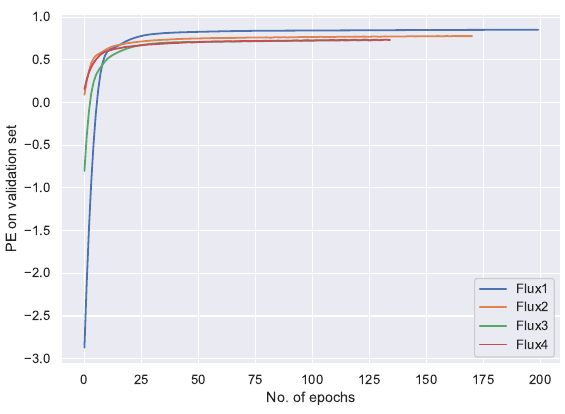
Figure 6. Predictive efficiency (PE) on validation set as a function of the number of epochs for Multi-Layer Perceptron (MLP) with input feature RL12A12 for the four targets (Flux1, Flux2, Flux3, and